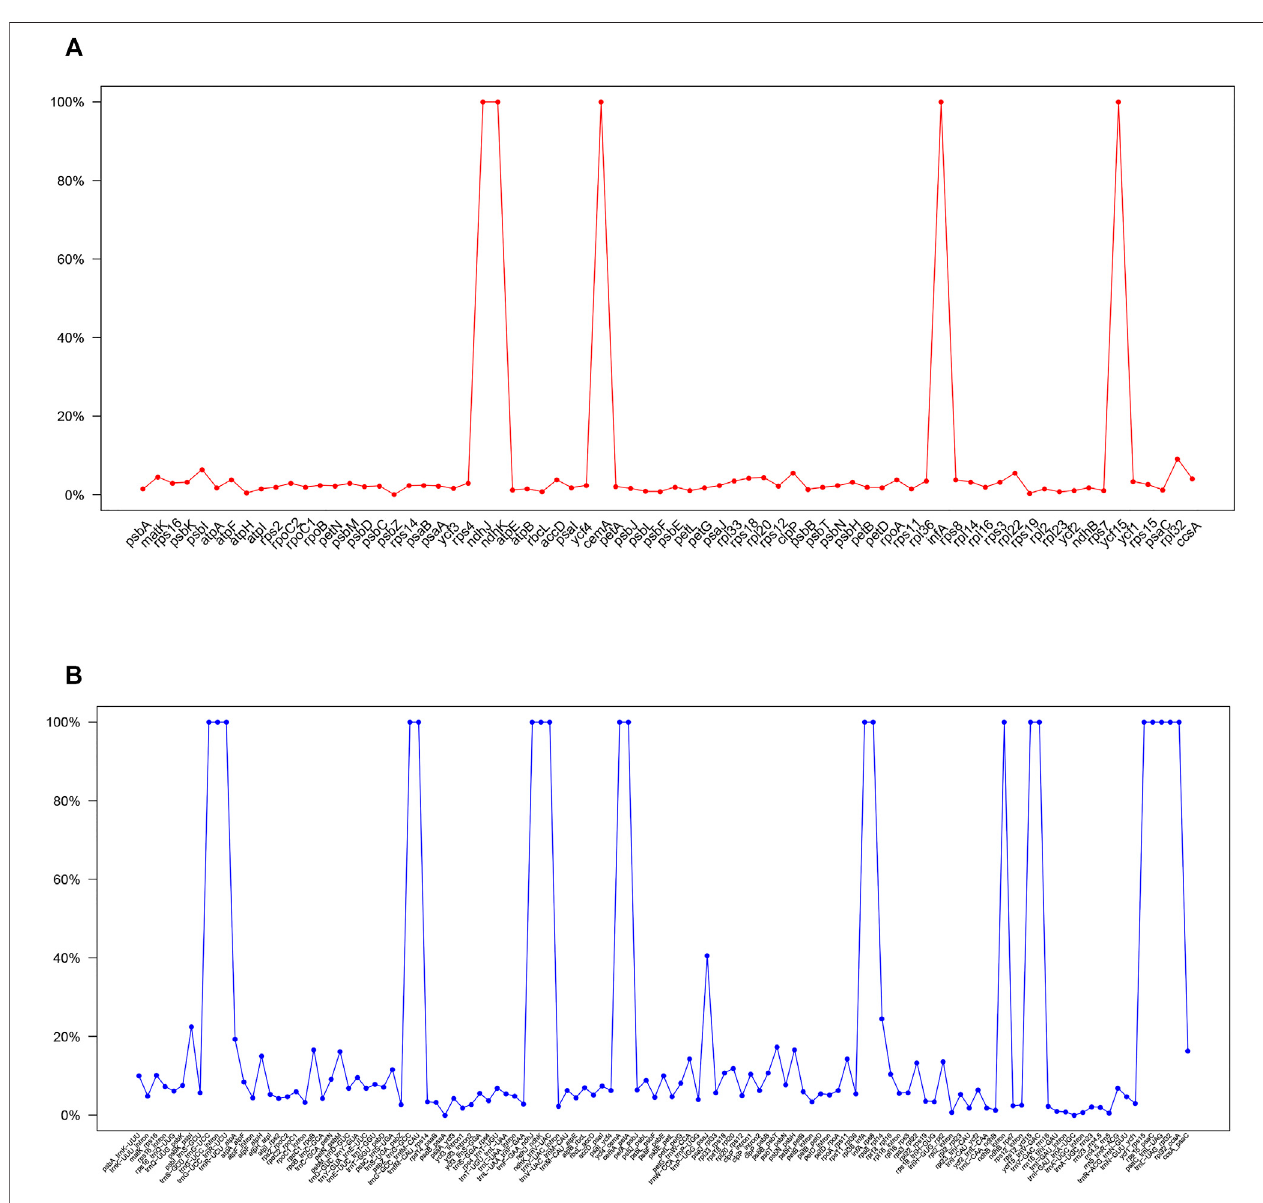
FIGURE 6 | Percentages of variable sites in homologous regions across the 9 Paphiopedilum species with complete chloroplast genomes. (A) protein coding sequences (CDS). (B) non-coding sequences.